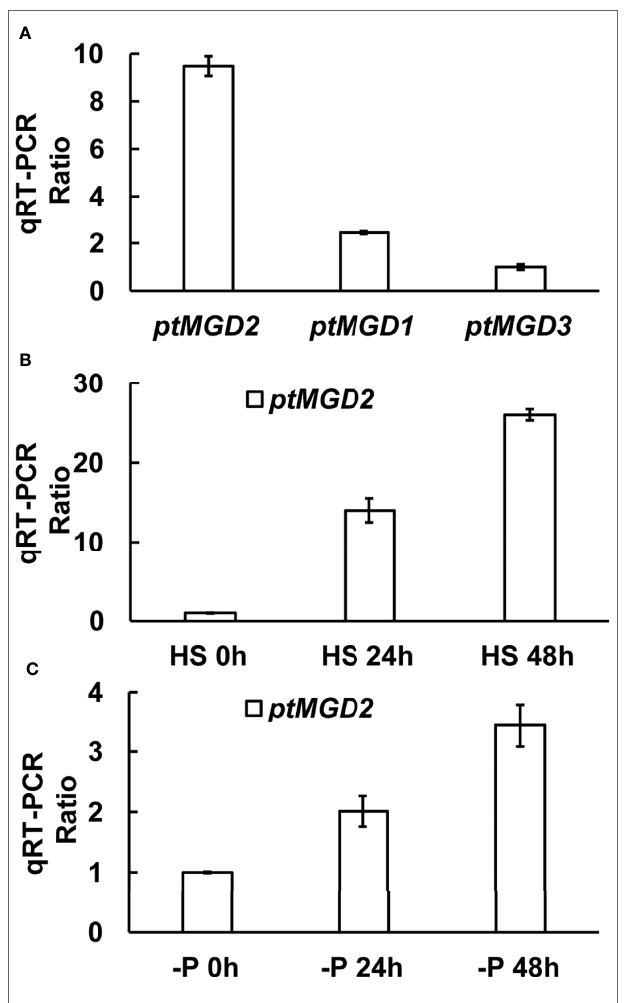
FIGURE 1 | The expression profile of ptMGD transcripts. (A) The expression levels of ptMGD genes under normal growth condition. (B, C) qRT-PCR was performed detect the ptMGD2 expression under high salt stress and phosphate-deprivation, respectively. HS indicates high salinity and -P represents phosphate-deprivation. All values represent means standard deviations of three biological